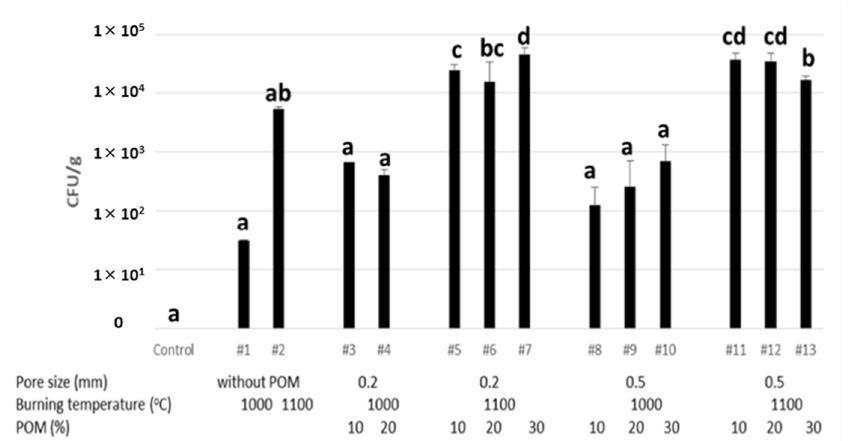
Figure 3. The cell numbers of GYP-74 adhered to the pottery shards (PSs). Bars denoted by the different letters are significantly different ( p > 0.05, Tukey-Kramer test). Values represent mean ± standard deviation ( n = 3).